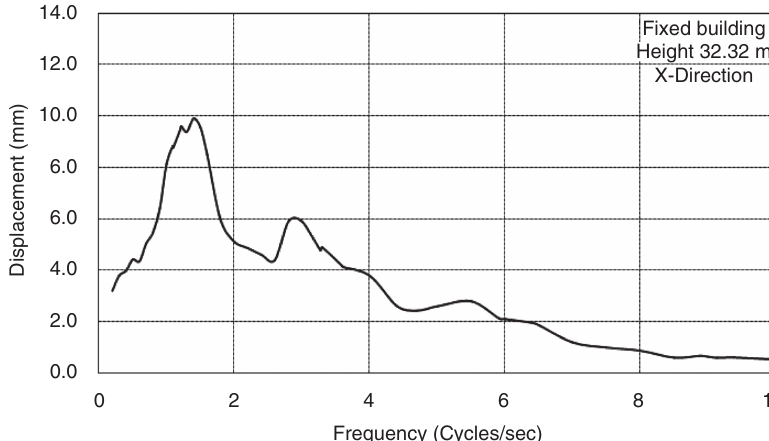
Fig. 10. Spectral Displacement in X-direction ( fi xed building)